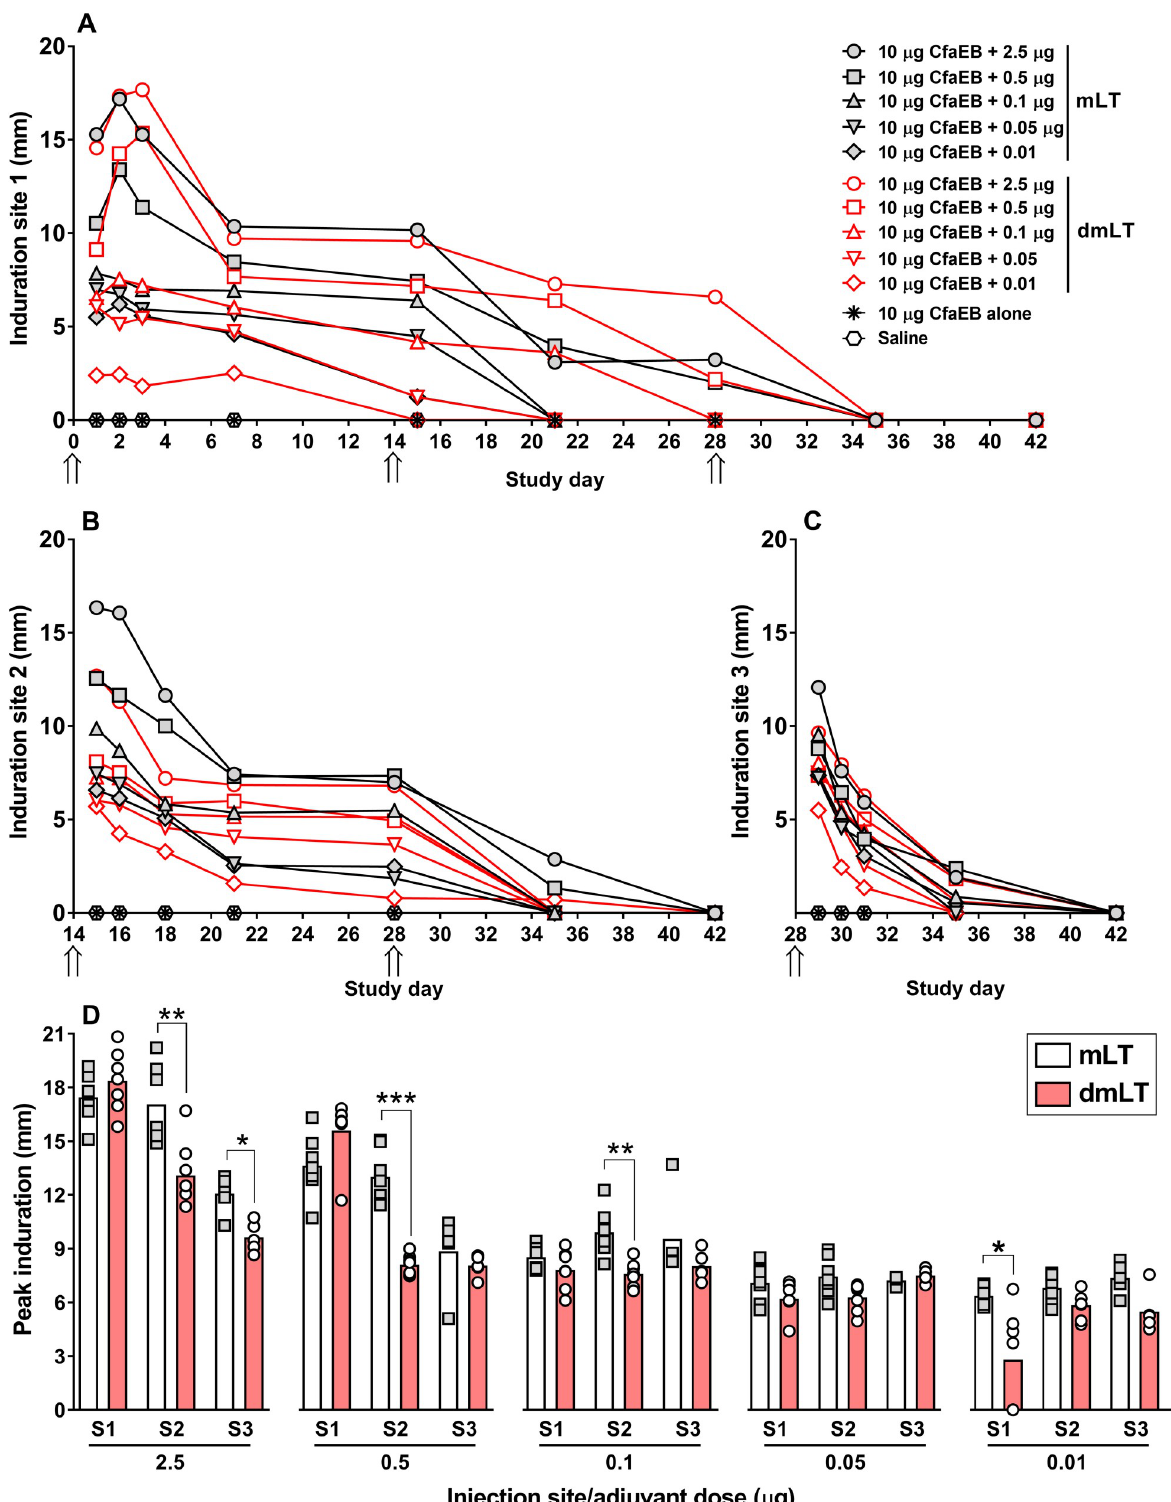
Fig 2. Skin induration. Induration was defined as the mean of the length and width in millimeters, measure on days 1, 2, 3, and every 7 days after each injection until resolution or the end of the study. (A-C) Induration measurements at S1, S2, and S3, respectively. The first (d0), second (d14) and third (d28) doses were administered at S1, S2, and S3, respectively. Data is shown as the kinetics of mean induration/group (n = 5-7/group/